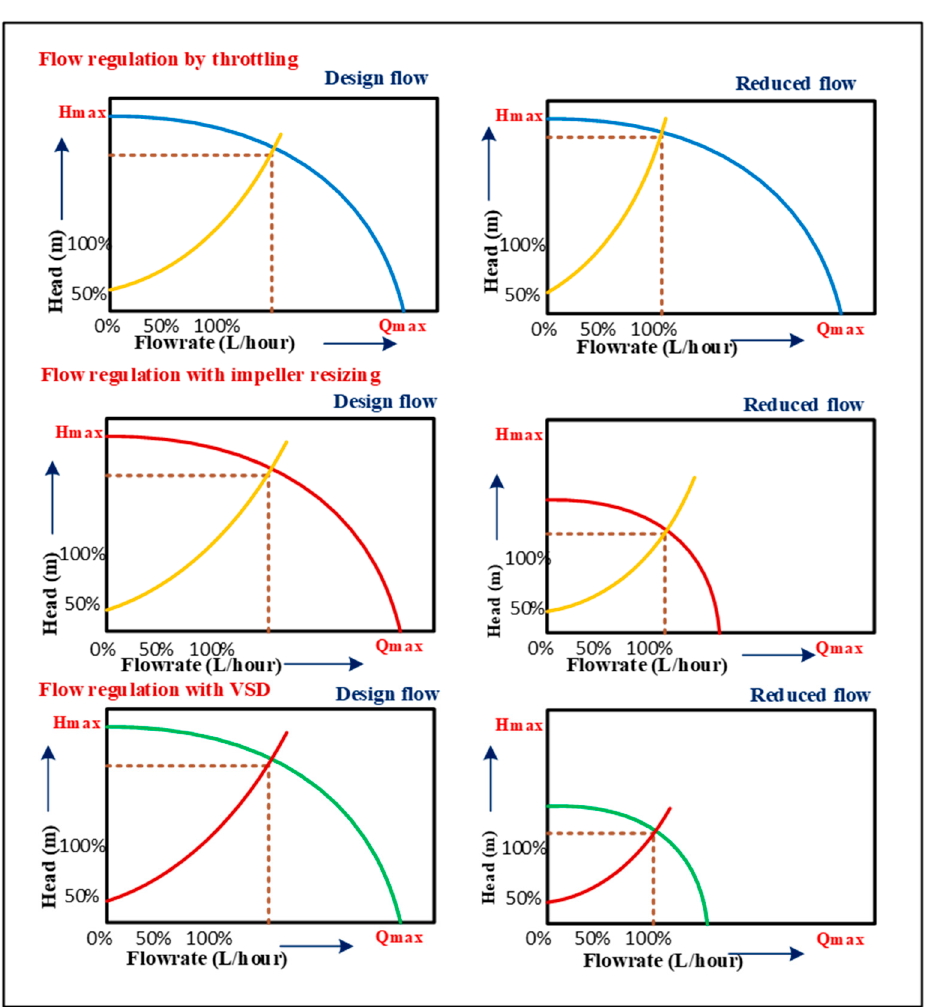
Figure 4. Various flow regulation strategies on energy consumption (Reprinted from:www.iipinetwork.org. Accessed from 29 January 2022).